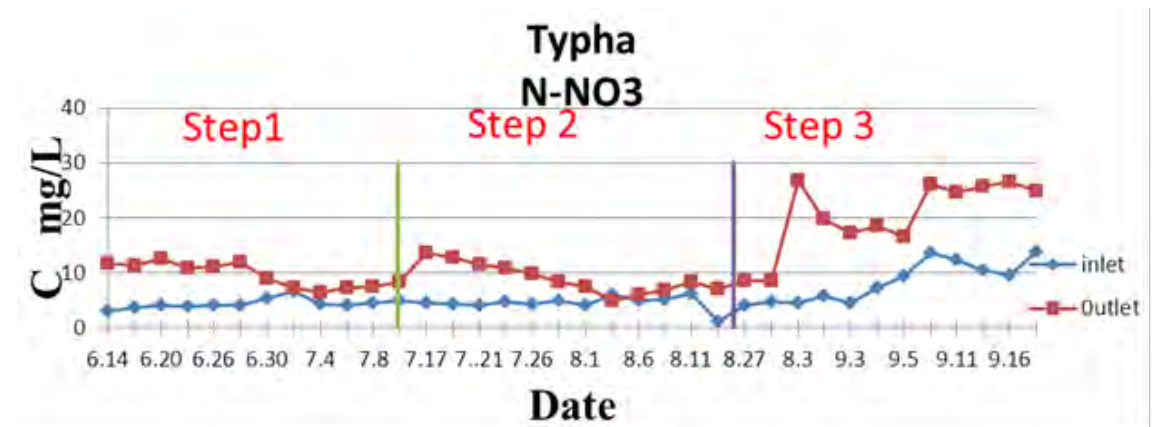
Figure 15. Efficiency removal of N-NO 3 IN Typha tanks during three surface loads (8,6,4)m 3 /m 2 .h and two circulation ratios (10%, 20%) for each load and for one week time for each different